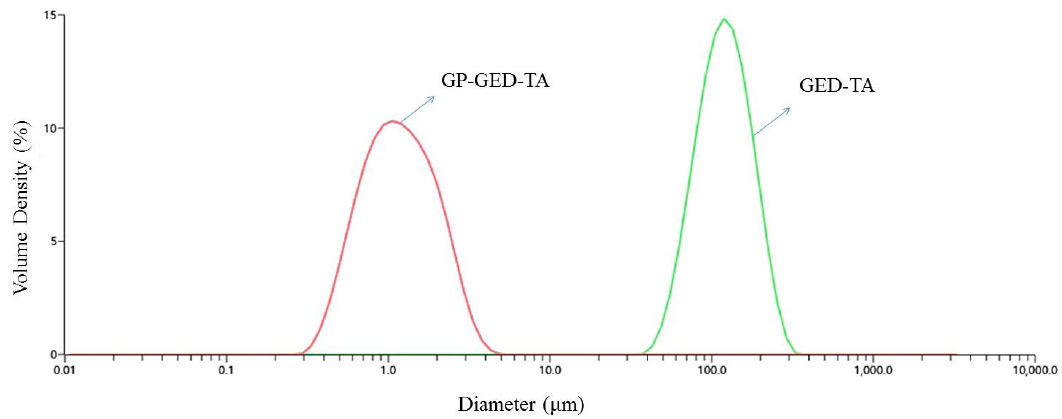
Figure 8. The size distribution curves of oil droplets stabilized by GP-GED-TA and GED-TA.